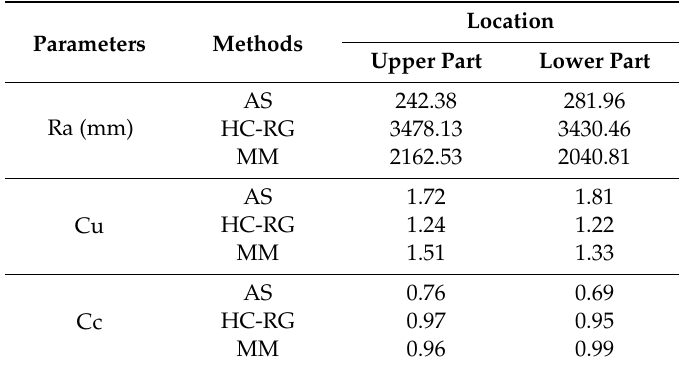
Table 2. Comparison of distribution characteristic parameters among upper and lower part of landslide